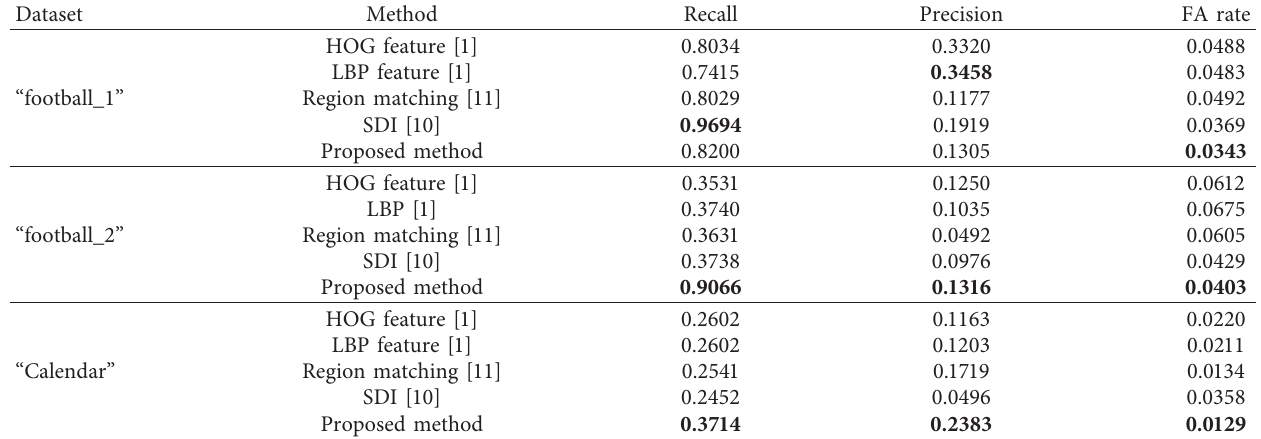
Table 1: Mean values of recall, precision, and FA rate computed from datasets.